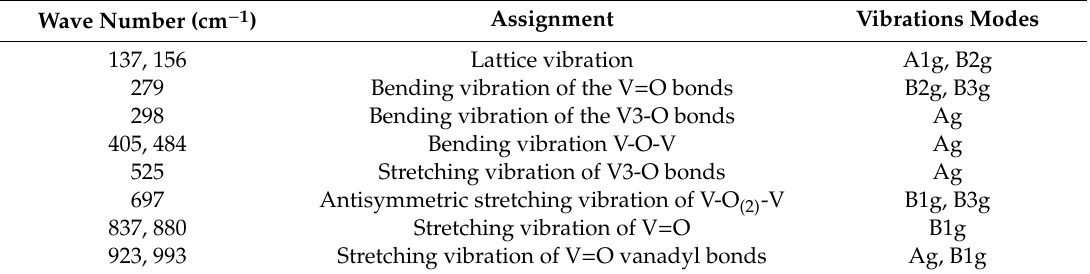
Table 2. The Raman spectra peaks and their